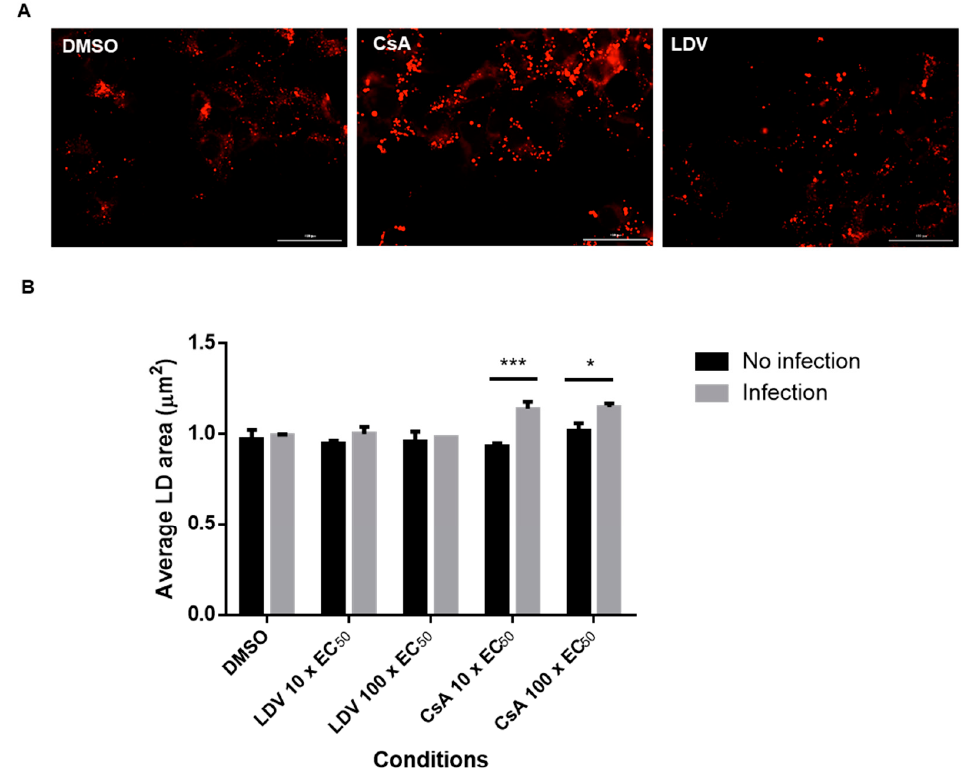
Figure 4. Changes in the LD area following treatment with CsA. Jc1/Gluc2A-virus-infected Huh-7.5.1 cells were treated with DMSO (10 × EC 50 or 100 × EC 50 ) of LDV or CsA for 8 h. The cells were fixed and stained with HCS LipidTox Deep Red Neutral Lipid Stain to label the LDs. Images were acquired on a BioTek Cytation 5 cell imaging multi-mode reader with 40× objective and analyzed by BioTek Gen5 software. ( A ) Representative images of LDs in cells treated with 100 × EC 50 LDV or CsA for 8 h. The scale bar represents 100 µm. ( B ) The average area of LDs for each treatment. Each data point represents the average value of 2 individual experiments. The error bars represent the SEMs. Statistical analysis was performed using 2-way ANOVA with Šidák’s multiple comparisons test. * p < 0.05, *** p < 0.001. CsA, cyclosporin A; LDV, ledipasvir.